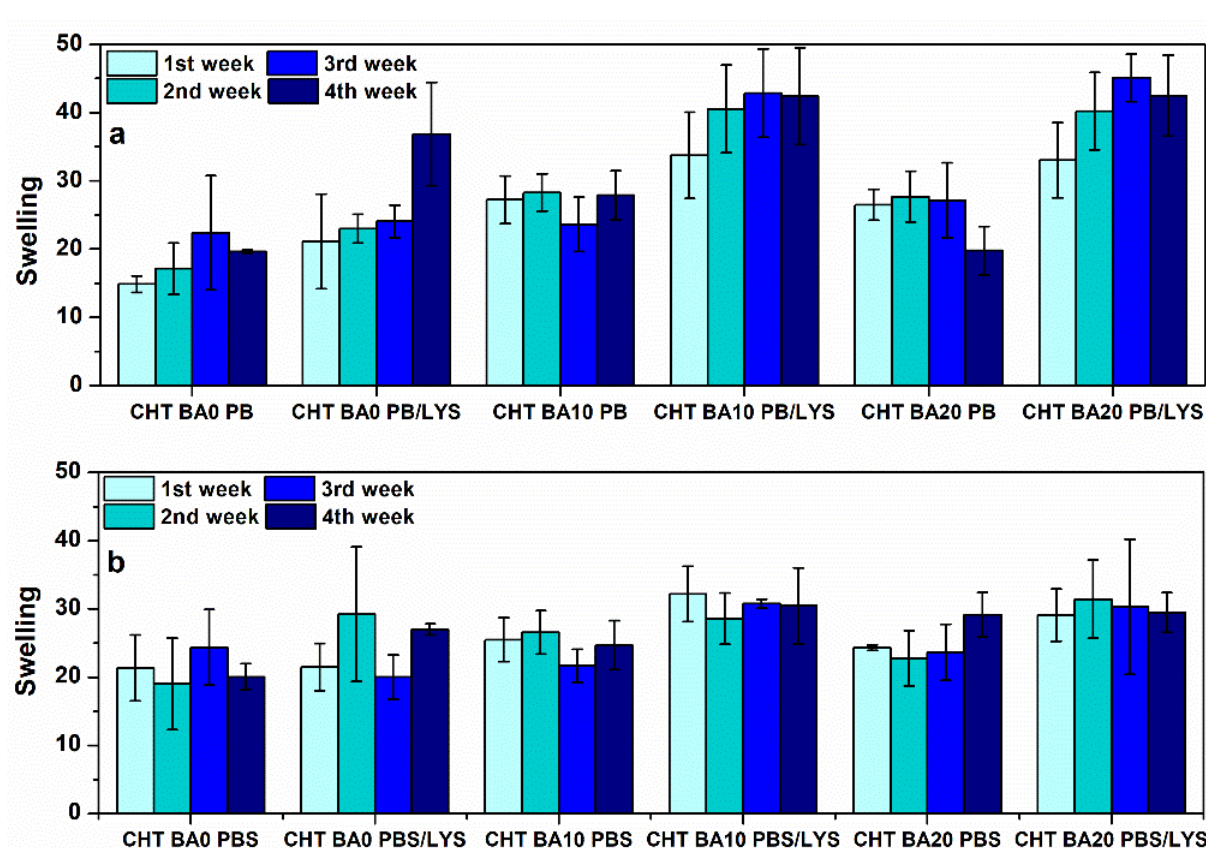
Figure A1. Swelling capacity of chitosan-boric acid scaffolds in ( a ) phosphate buffer (pH 6.0) and ( b ) phosphate-buffered saline solution (pH 7.4) with and without lysozyme.